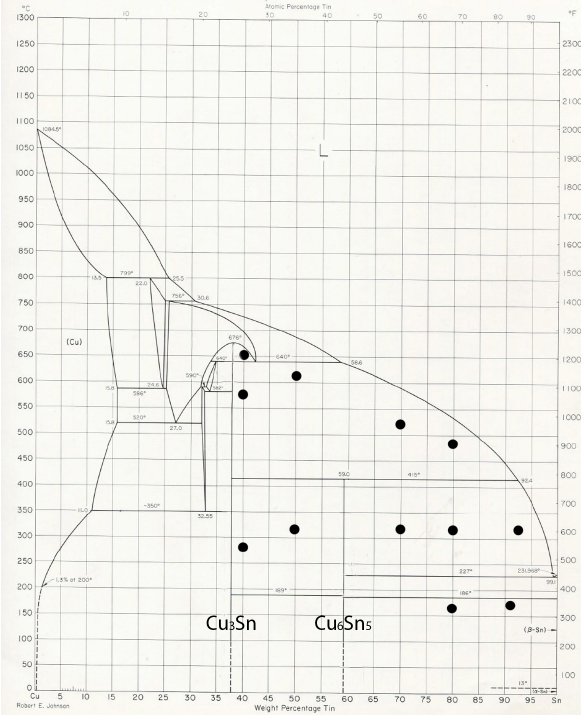
Figure 8: Cu-Sn phase diagram [21] with experimental points (from the left) 3,4,5,6,8 Table 1.